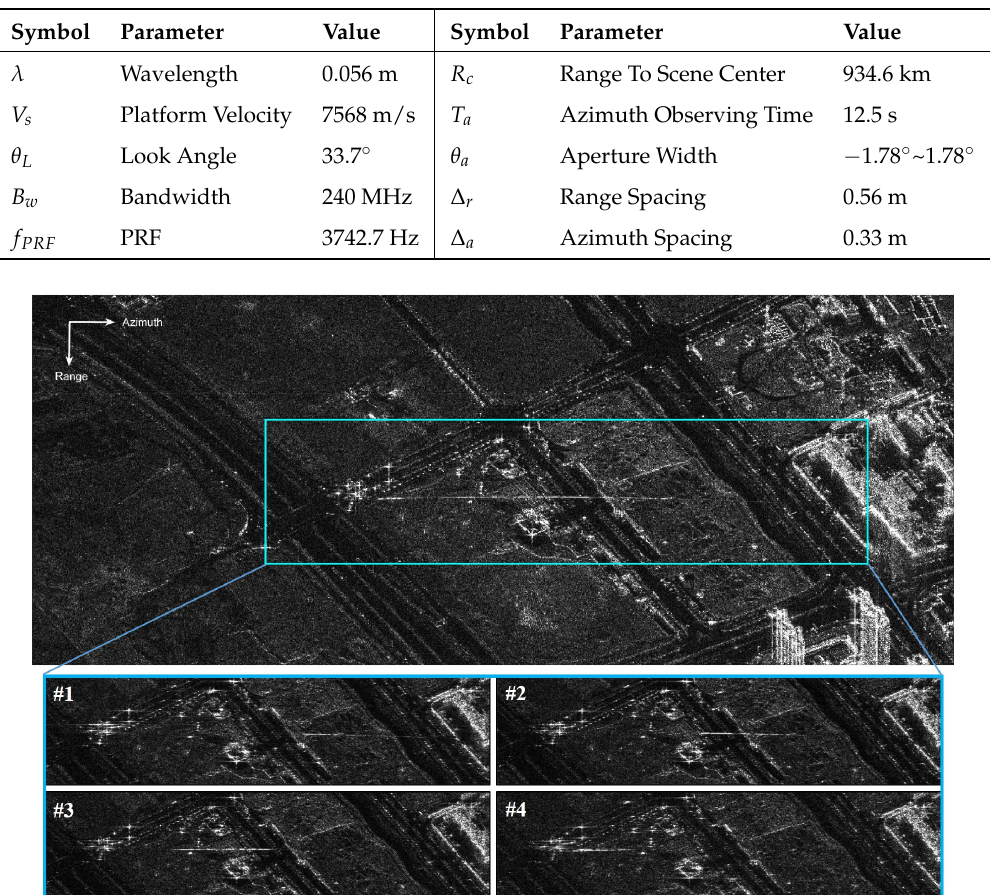
Figure 1. The upper SAR image shows the selected scene for test. The moving target signature is bounded by the blue box. To show the motion of moving target’s signature, four subaperture images of the area bounded by the blue box are generated as shown in bottom. From image 1 to 4, it is clear that the target signature moves from right to the